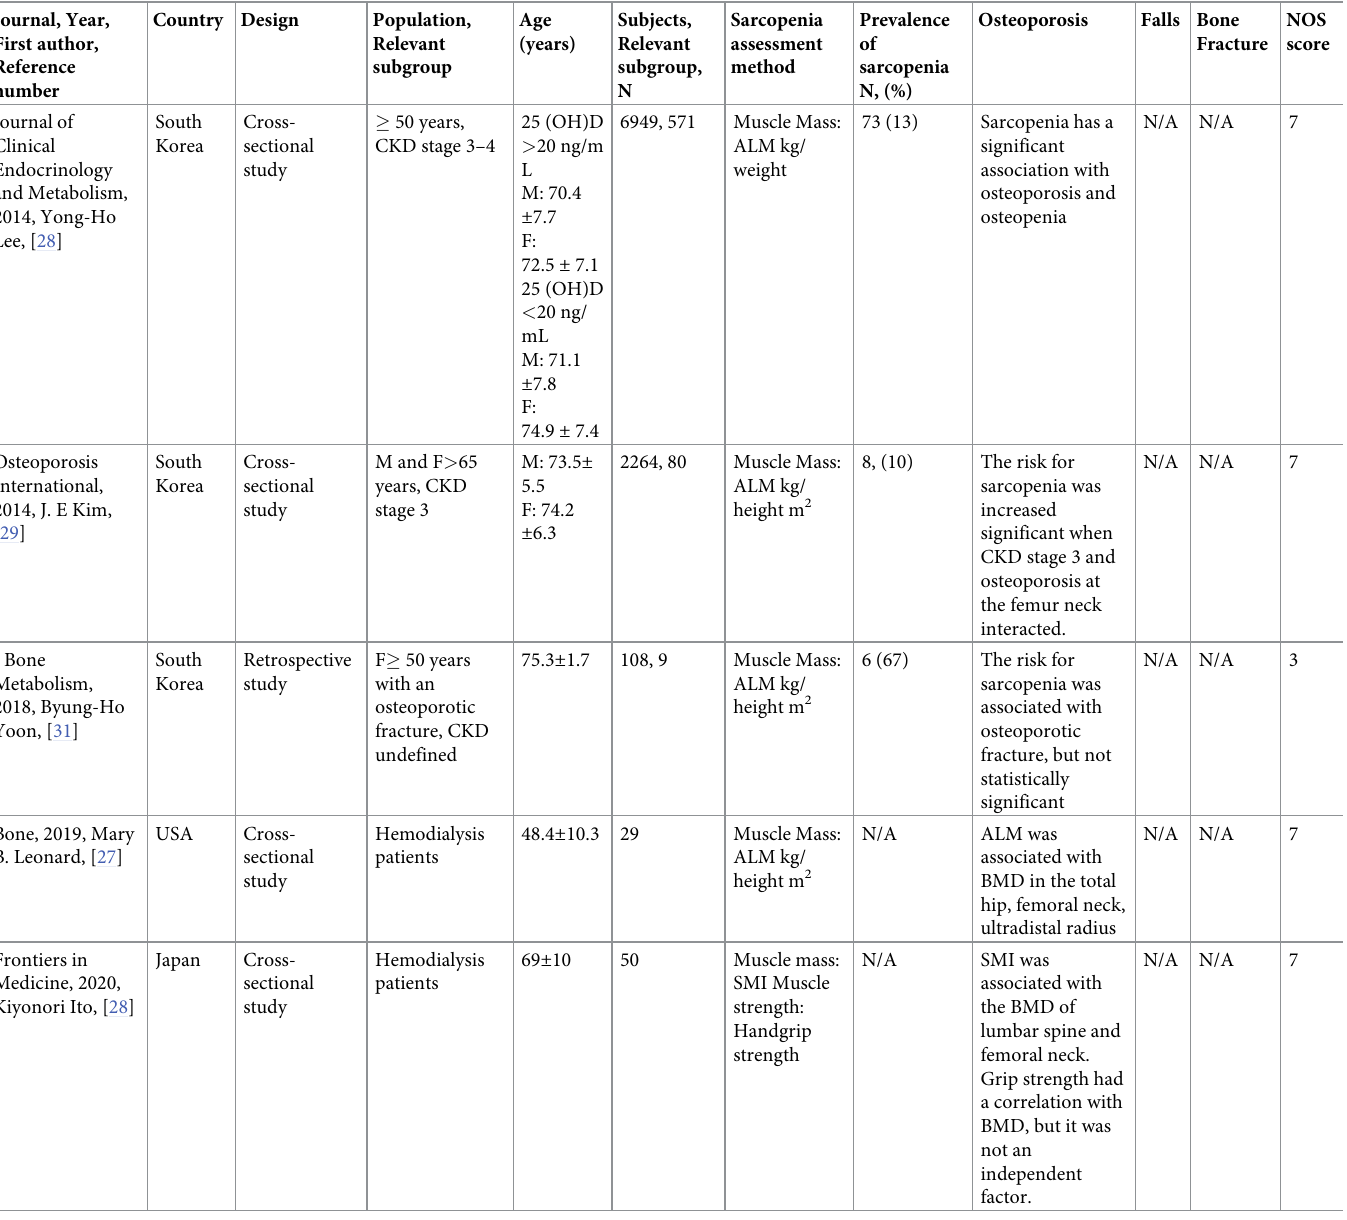
Table 1. Characteristics of included studies—osteoporosis, falls, and